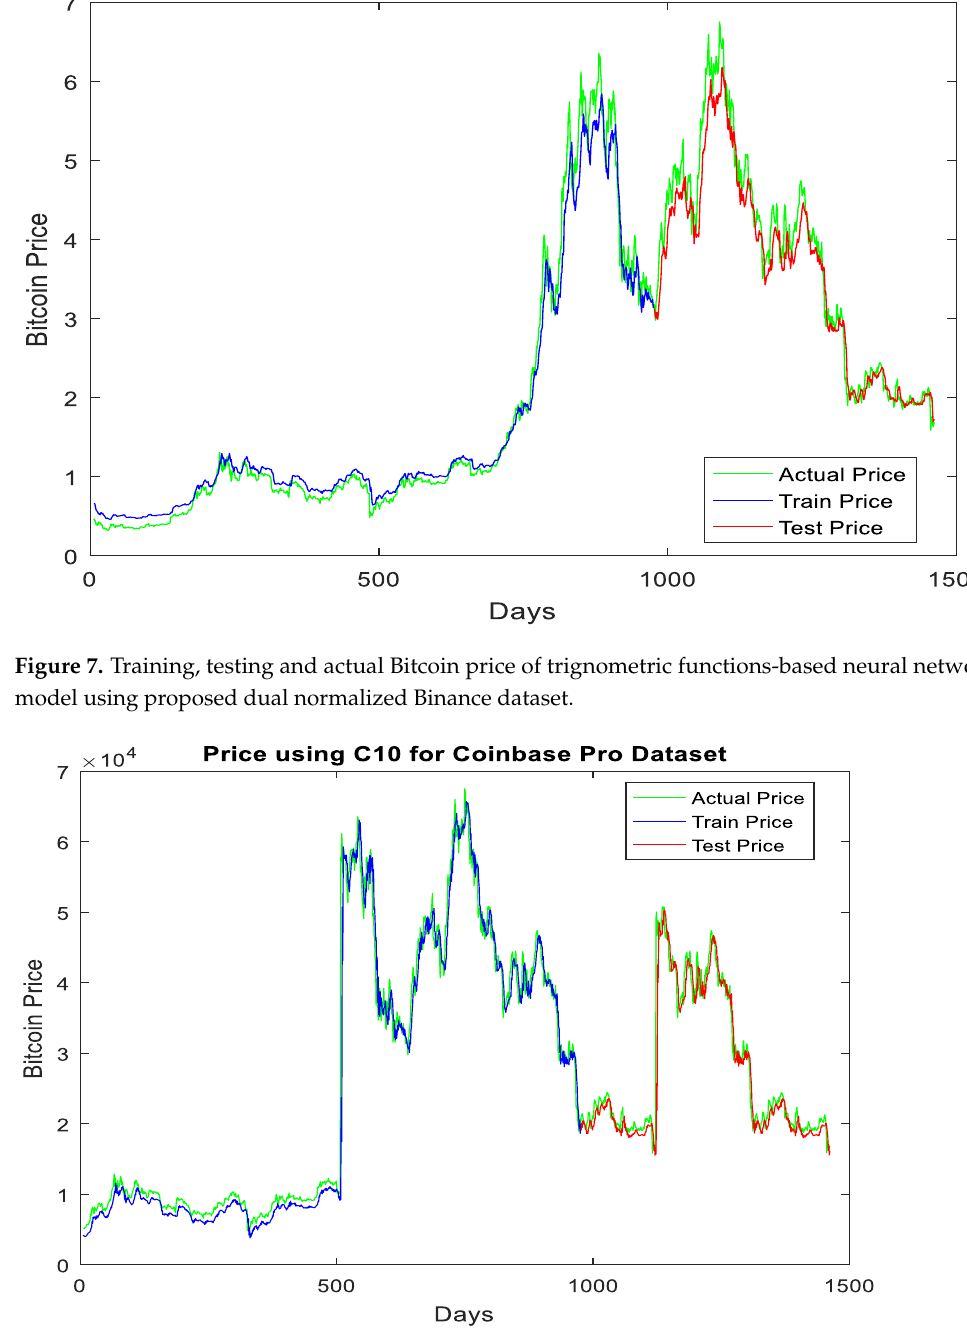
Figure 8. Training, testing and actual Bitcoin price of Chebyshev-based neural network model using proposed dual normalized Coinbase Pro dataset .